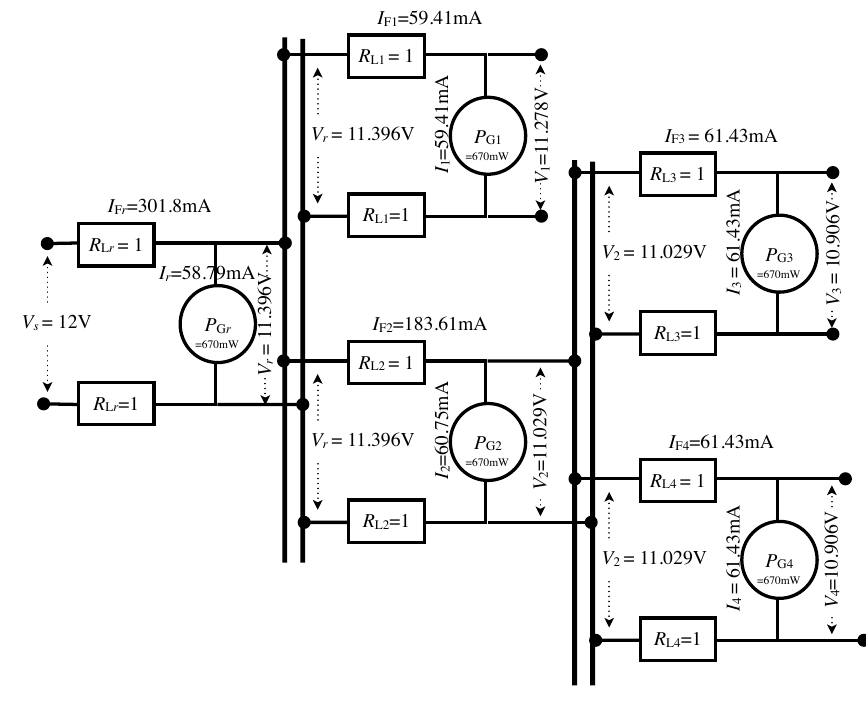
Figure 5. Example solution produced by the Ct() algorithm for the tree topology.